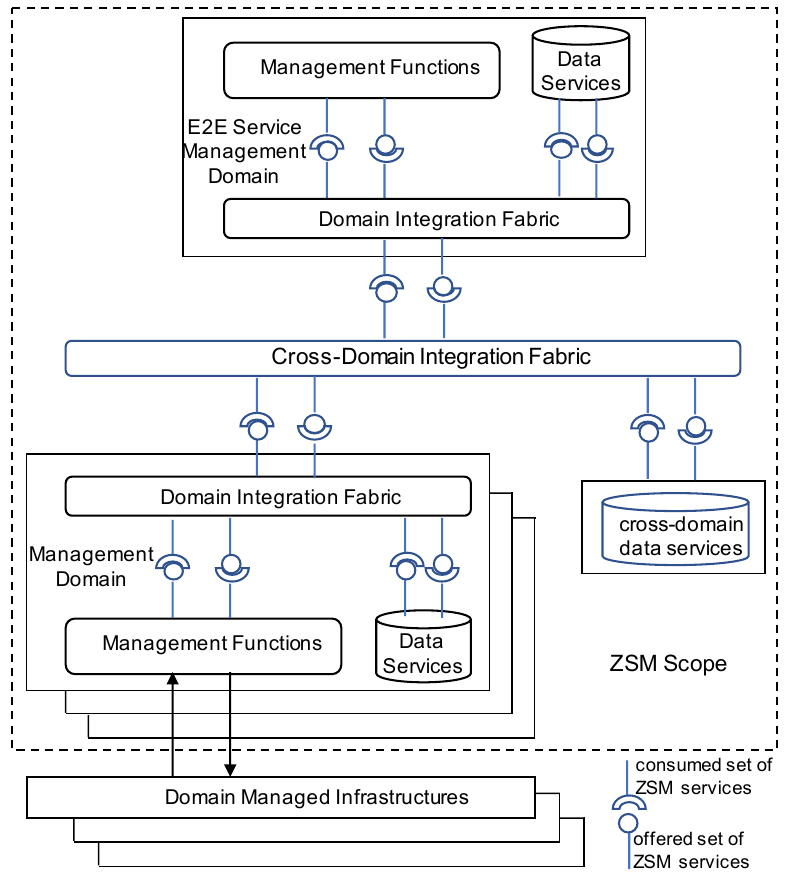
Figure 5. ETSI Zero Touch Network and Service Management (ZSM)